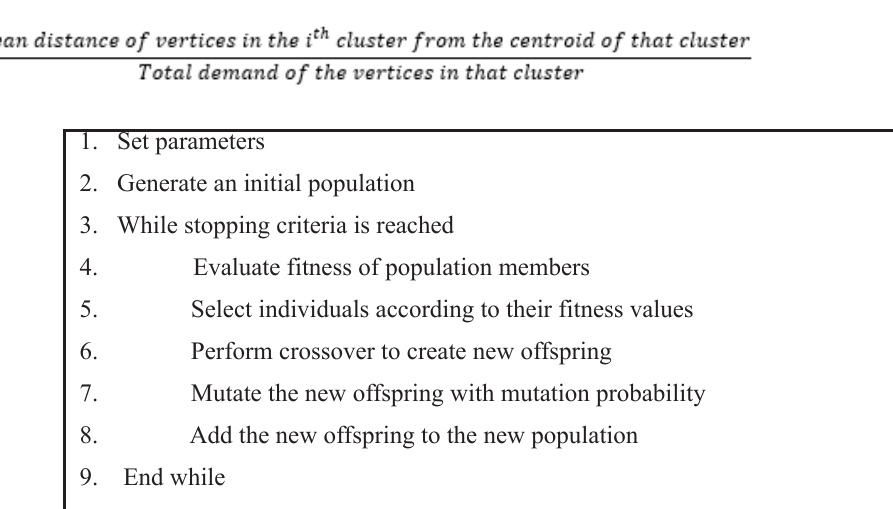
improved heuristic algorithm than the original